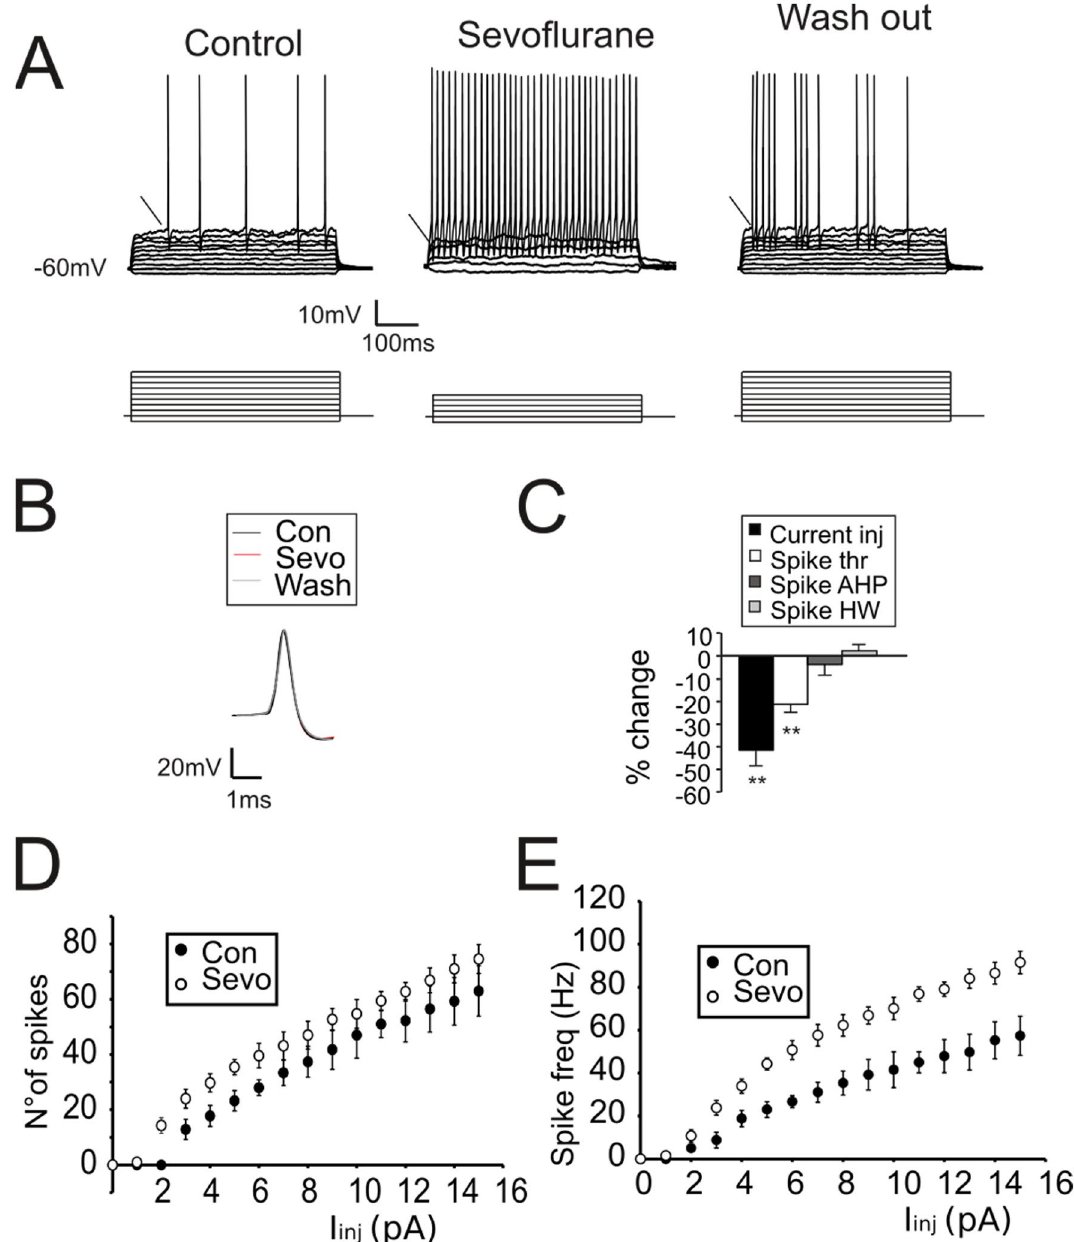
Figure 5. Sevoflurane increases GrCs intrinsic excitability. ( A ) GrC voltage responses to current injections (bottom traces 1 pA/step) in control conditions, during sevoflurane perfusion and following wash-out of the anesthetic. Note, during sevoflurane, less injected current is needed to generate action potentials, the number of elicited spikes is increased, the firing threshold is lowered (arrow) and firing discharge becomes regular. ( B ) Comparison of action potential waveform obtained in control (black), in the presence sevoflurane (red trace) and following wash-out (gray trace). Note that sevoflurane did not affect the spike shape. ( C ) Histogram shows the changes induced by sevoflurane on the current needed to bring GrCs to the firing zone (current inj), spike threshold (spike thr), spike after hyperpolarization (spike AHP) and spike half-width (spike HW) (n = 7). ( D ) Relationship between the injected current and the total number of emitted spikes (n = 7 cells). E Relationship between the injected current and the average firing frequency of the emitted spikes (n = 7